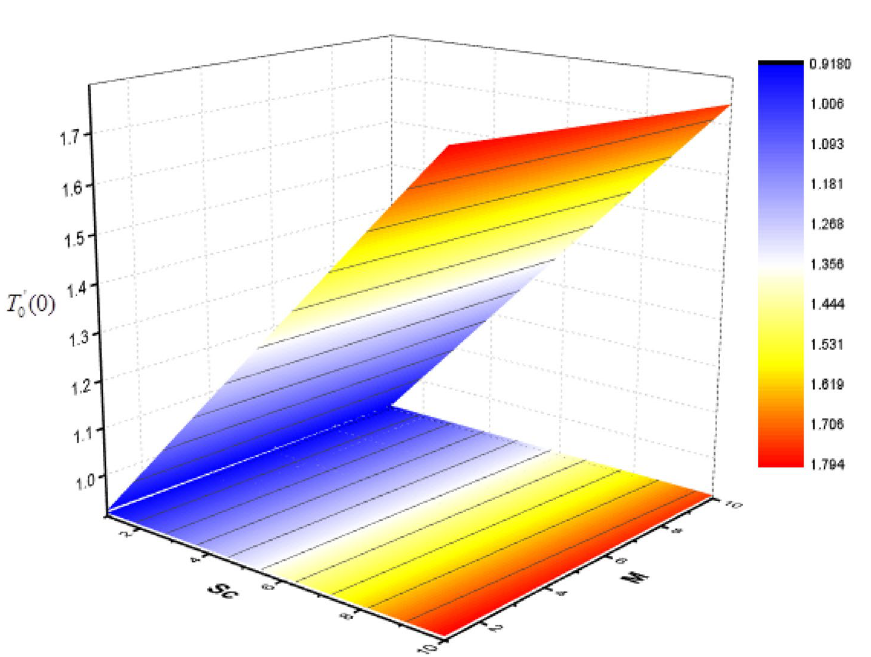
Figure 24. Consequence of Sc and M on T ′ 0 ( 0 )